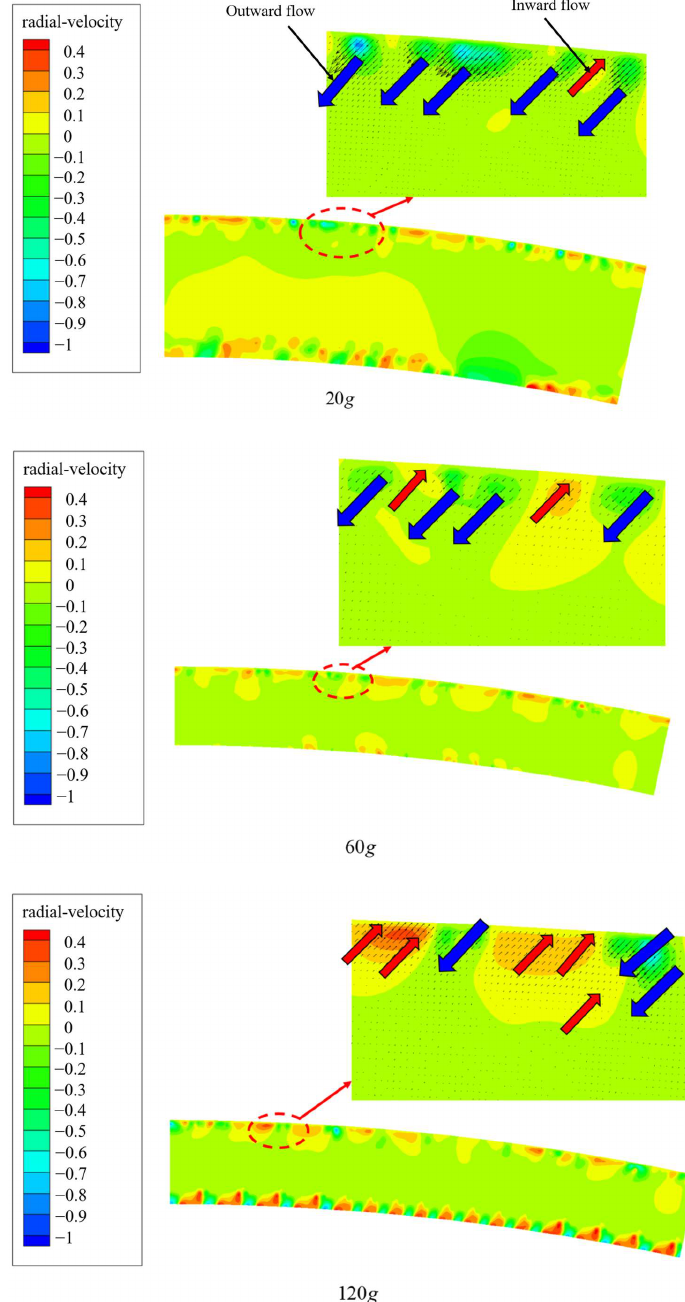
Figure 16. The streamline of the liquid film under different centrifugal accelerations.